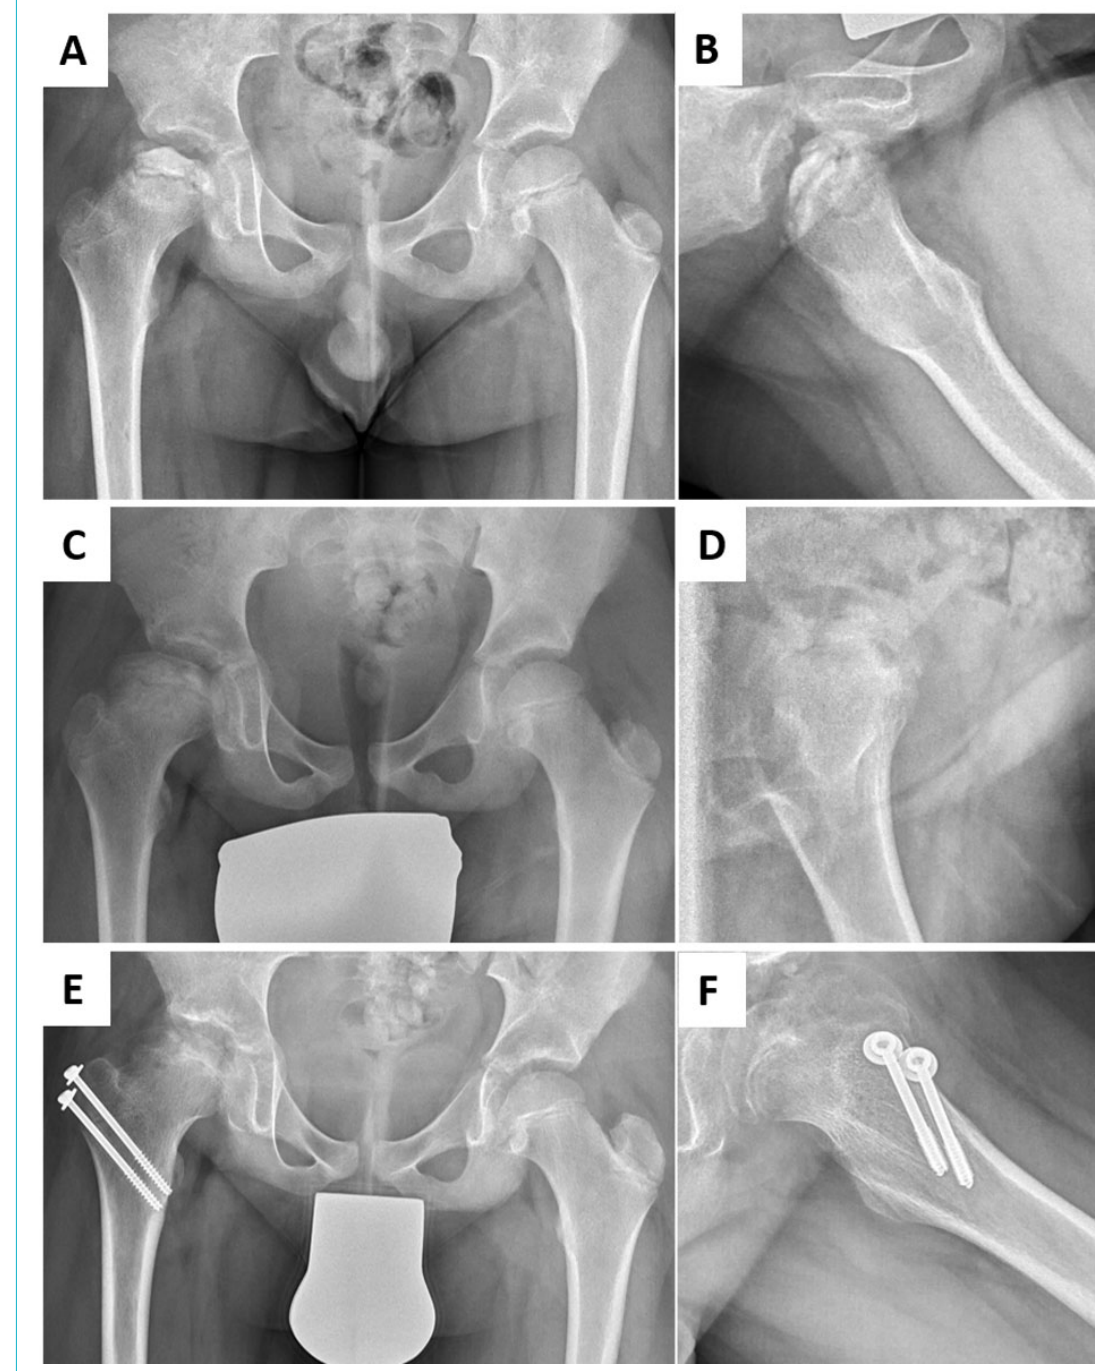
Figure 2: Osteochondral lesions at the hip site following Legg-Calvé-Perthes (LCPD) disease. (A, B) Radiographs in anteroposterior or Lauen- stein projections of the hips of a 7-year-old boy with LCPD of the right hip (Catterall Group 4, Lateral Pillar Group C), indicating femoral head containment. (C, D) Radiographs in anteroposterior or Lauenstein projections taken at 15-month follow-up confirm acceptable containment with an enlarged but spherical femoral head after non-surgical treatment. (E, F) Radiographs in anteroposterior or Lauenstein projections